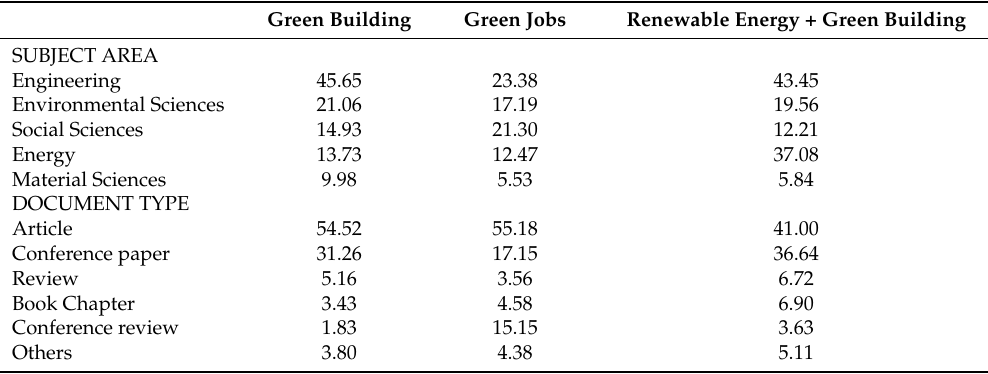
Table 2. Main subject areas and documents type